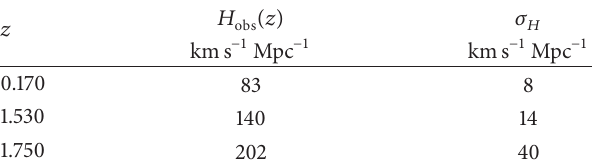
Table 1: Hubble parameter versus redshift